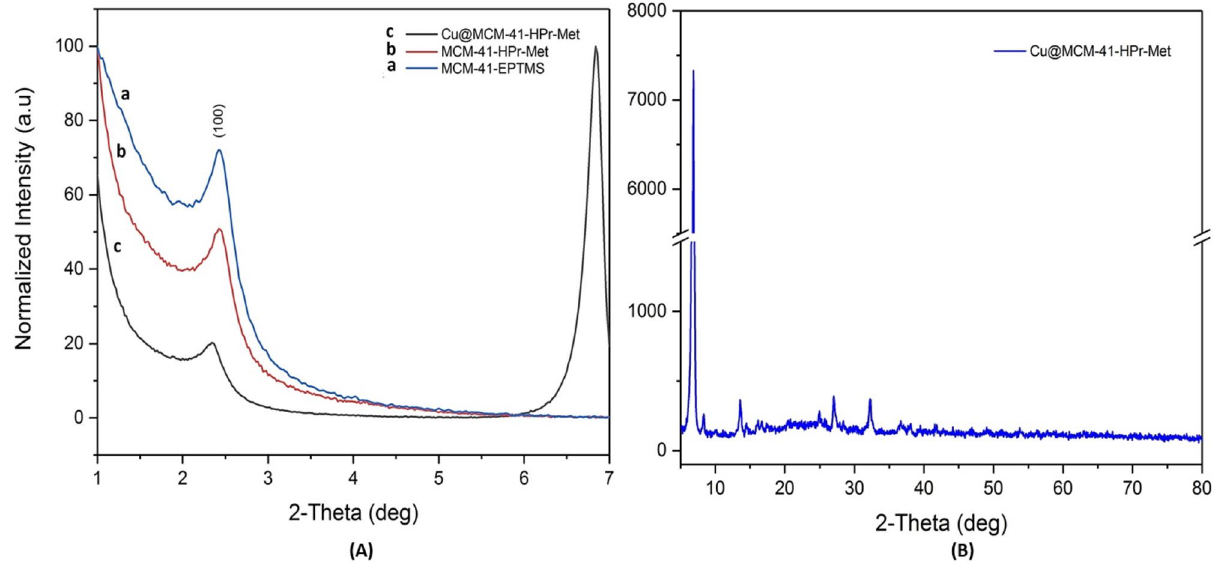
Figure 1. ( A ) The low-angle XRD patterns of a: MCM-41-EPTMS, b: MCM-41-HPr-Met c: Cu@MCM-41- HPr-Met, ( B ) XRD pattern of